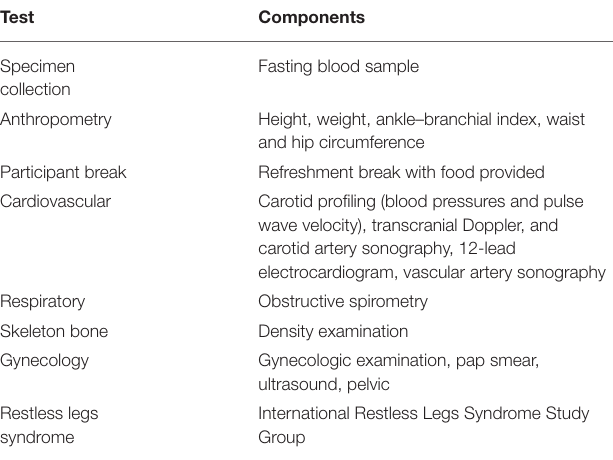
TABLE 1 | Testing program in the Jidong Restless Legs Syndrome Cohort